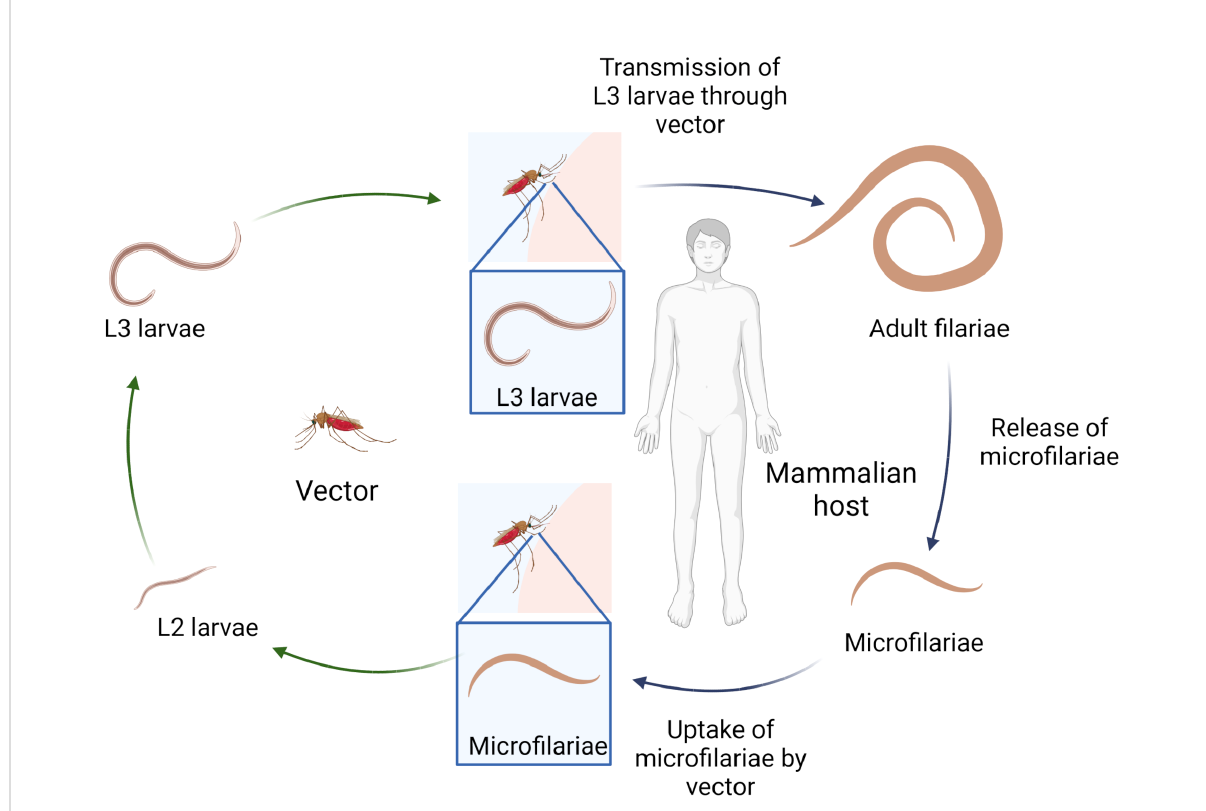
FIGURE 1 Filarial life-cycle. Created with